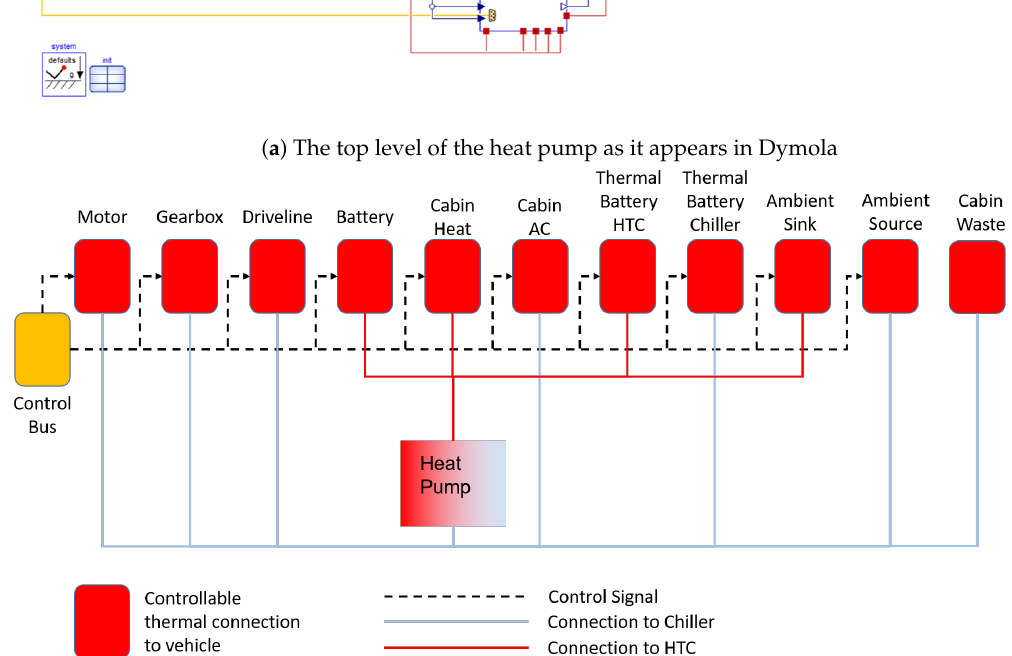
Figure 2. The uppermost level of the heat pump, where thermal connections across the vehicle are made and controlled. In the centre is the middle layer of the heat pump, which contains the physical models of the coolant and refrigeration